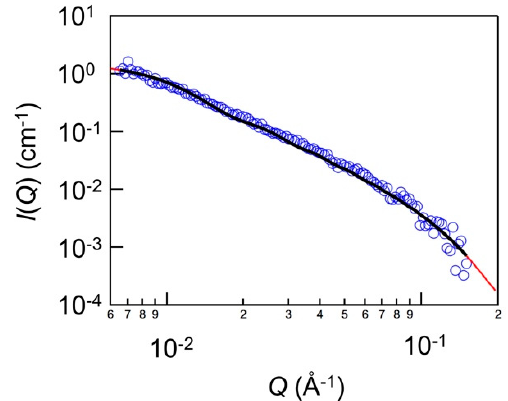
Figure 7. SANS profiles for the laponite dispersion in D 2 O. The solid line in the figure represents the fitting curve with Equation (1).